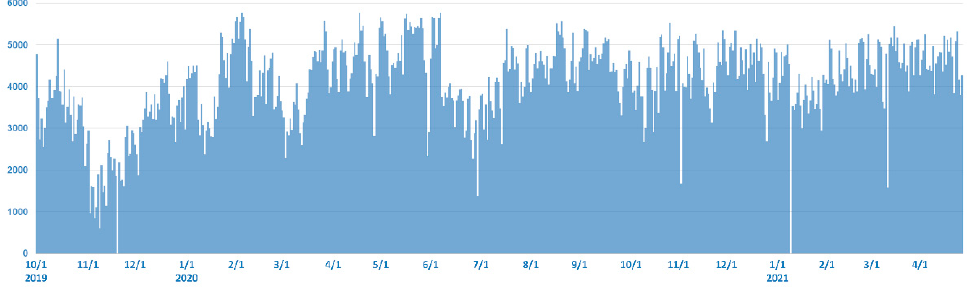
Figure 1. The daily number of the COSMIC-2/FORMOSAT-7 RO profiles from 1 October 2019 to 26 April 2021.